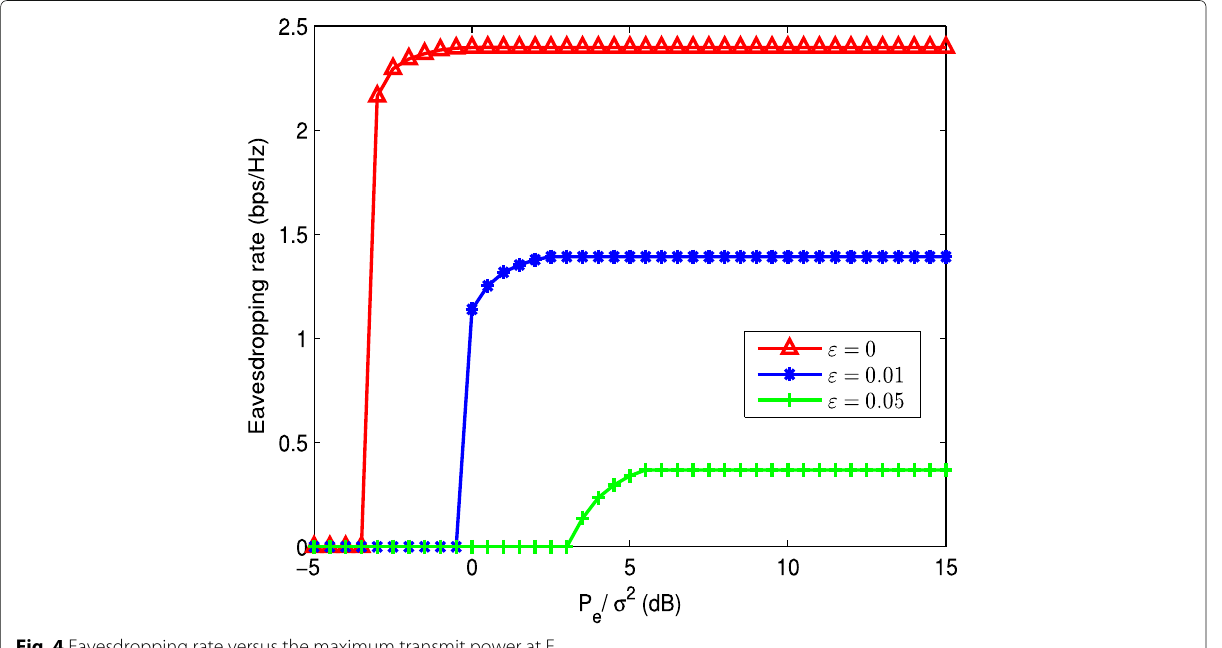
Fig. 4 Eavesdropping rate versus the maximum transmit power at E successful eavesdropping to the sum eavesdropping, suc- cessful eavesdropping is defined as the cases that the eavesdropping rate can not be larger corresponding to the known conditions. P t /σ 2 = P e /σ 2 = 10 dB while (cid:7)/σ 2 is in the range of [ − 10 dB, 10 dB]. Note that ε = 0 corresponds to the scenario when perfect knowl- edge of all the channels is known. In such a scene,